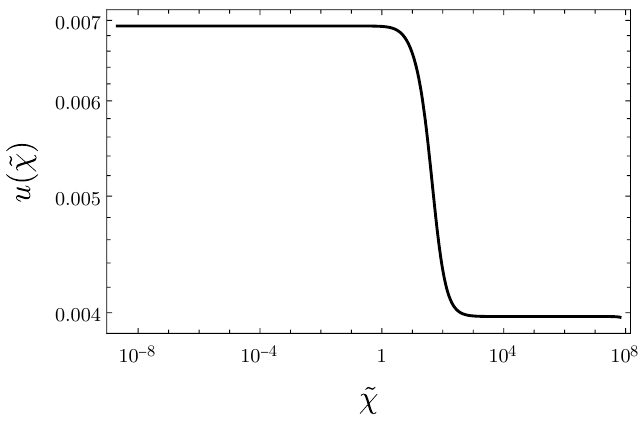
Figure 1 . Scaling function w (˜ χ ) for the coefficient of the curvature scalar (dimensionless squared effective Planck mass). While w (˜ χ ) becomes almost constant for small ˜ χ = χ/k , it increases ∼ ˜ χ 2 for large ˜ χ . For large scalar fields χ the effective Planck mass is proportional to χ .